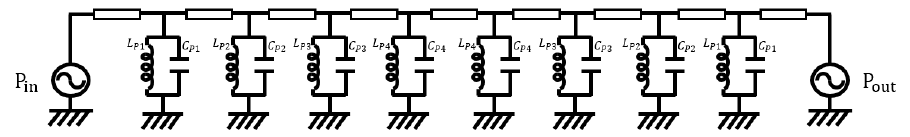
Figure 1. Equivalent circuit network of the bandpass filter.